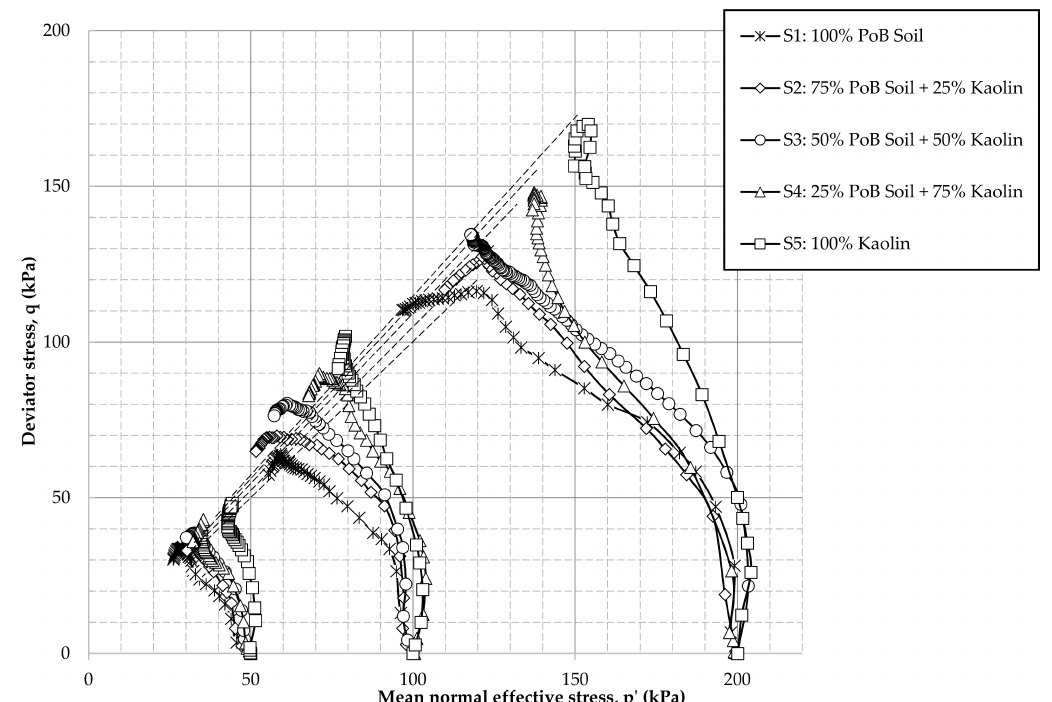
Figure 4. Effective stress paths for different confining pressures with varying silt contents (S1 represents 100% PoB soft soil; S2 represents 75% PoB soft soil + 25% kaolin soil; S3 represents 50% PoB soft soil + 50% kaolin soil, S4 represents 25% PoB soft soil + 75% kaolin soil; and S5 represents 100% kaolin soil; while 50,100, and 200 refer to the confining pressure.).